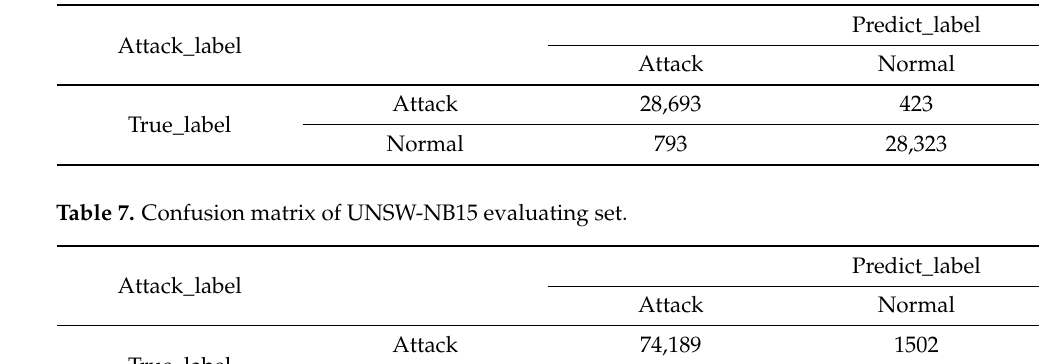
Figure 17. KDD99 evaluating set. Green indicates normal data and red indicates abnormal data. Table 6. Confusion matrix of WSN-DS evaluating set.